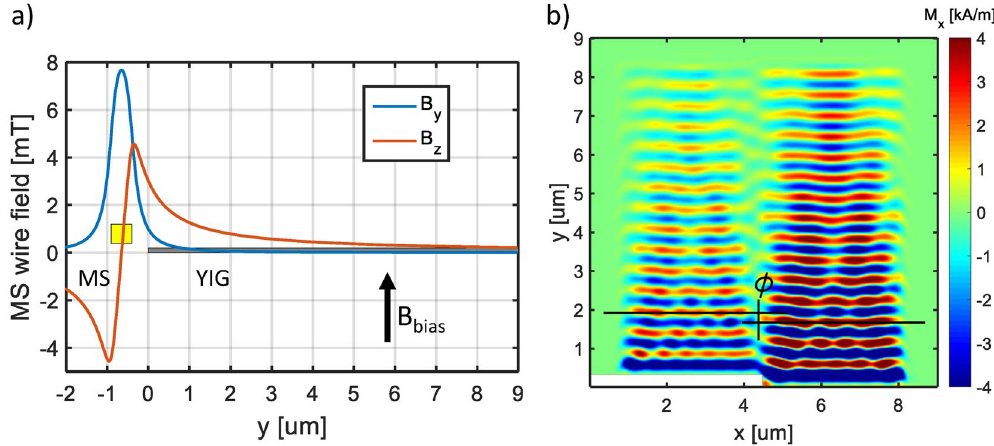
Figure 5. Spin-wave generation on the edge of a YIG film by a microstrip line (MS). ( a ) Magnetic field of MS and schematics of arrangement. ( b ) Time snapshot of the magnetization of YIG showing spin waves